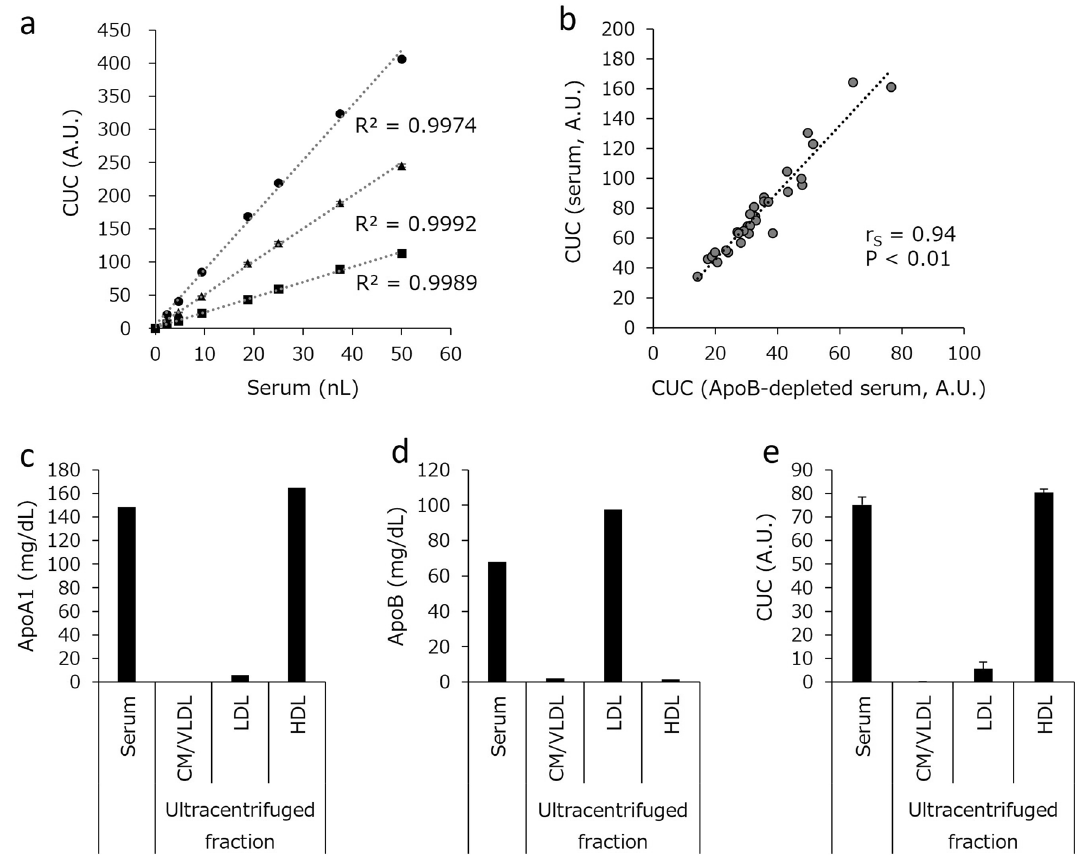
Figure 1. Dilution linearity of CUC and specificity of the automated CUC assays. ( a ) Serial dilutions of pooled serum samples with high (circle), middle (triangle), and low (square) CUC were analyzed. ( b ) CUC of serum and of the corresponding ApoB-depleted serum was measured, and Spearman’s rank correlation coefficient (r S ) between them was assessed. HDL and other lipoprotein fractions (CM/VLDL, LDL) were extracted from the pooled sera and ApoA1 ( c ), ApoB ( d ), and CUC ( e ) were measured in each fraction. The values in ( a ) and ( e ) represent the mean of triplicate determinations; error bars indicate SD. The values in ( b – d ) represent the average of duplicate determinations (CUC) or single determinations (ApoA1 and ApoB). A.U. arbitrary units.